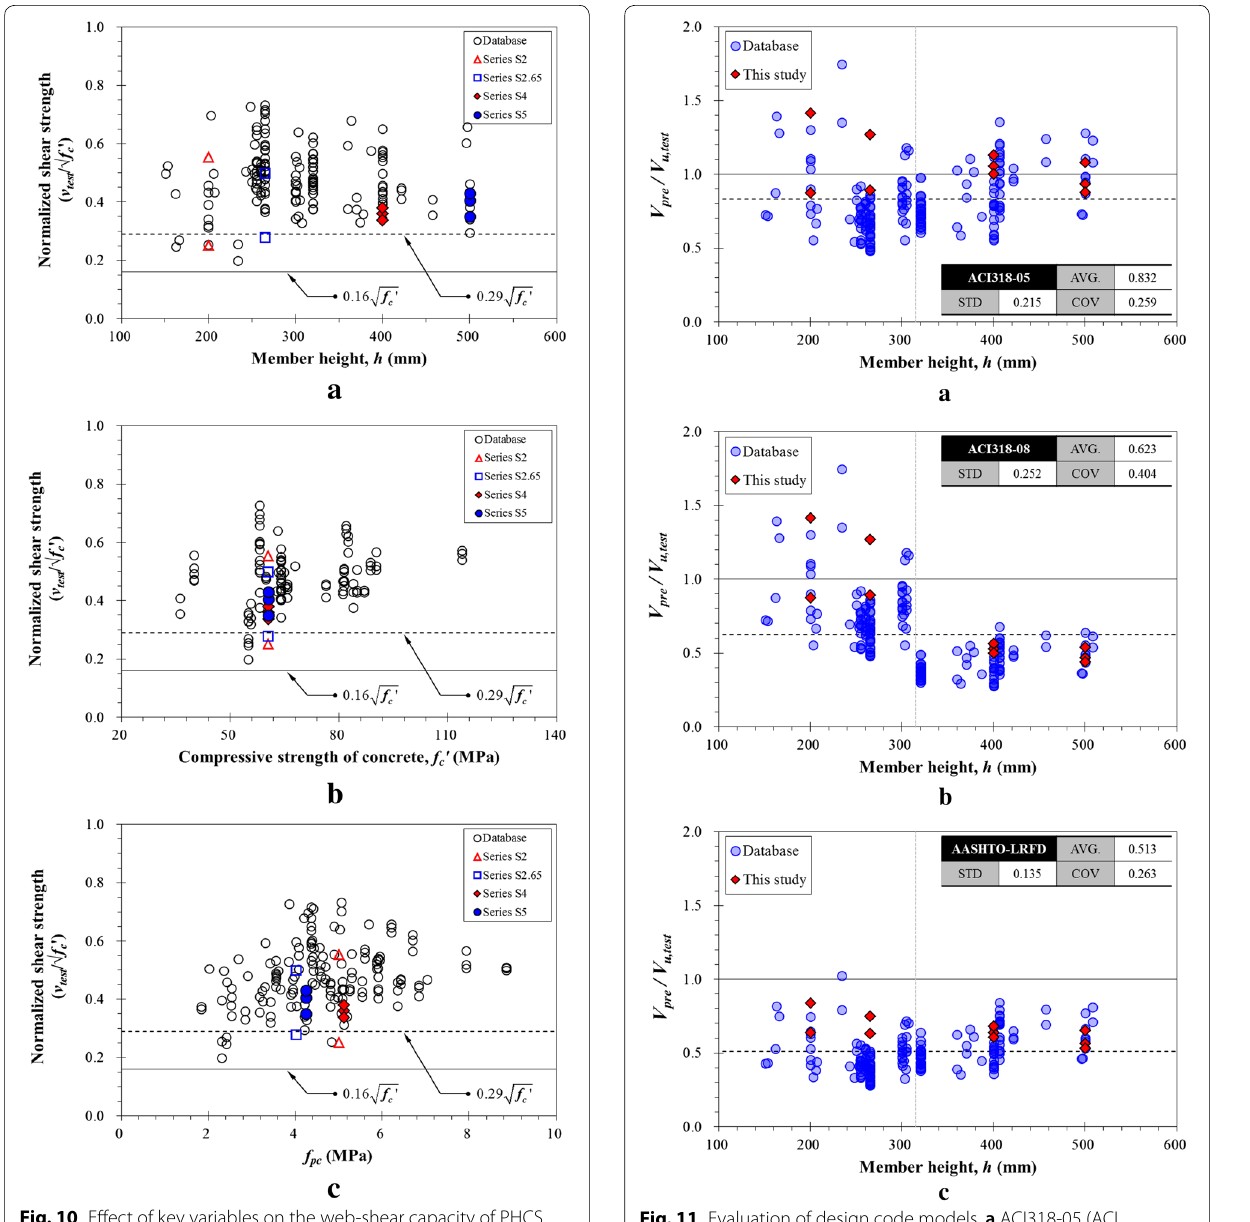
Fig. 11 Evaluation of design code models. a ACI318‑05 (ACI Committee 318 2005), b ACI318‑08 (ACI Committee 318 2008), c AASHTO‑LRFD (AASHTO